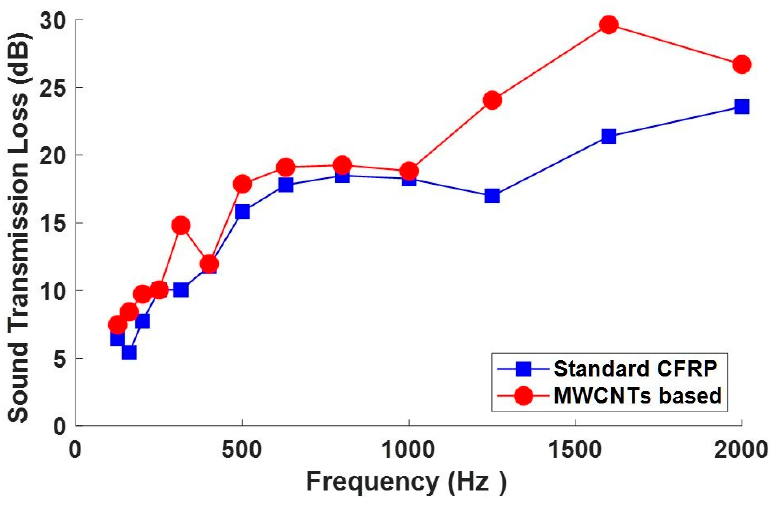
Figure 20. Transmission Loss. CFRP is carbon fiber reinforced panel.